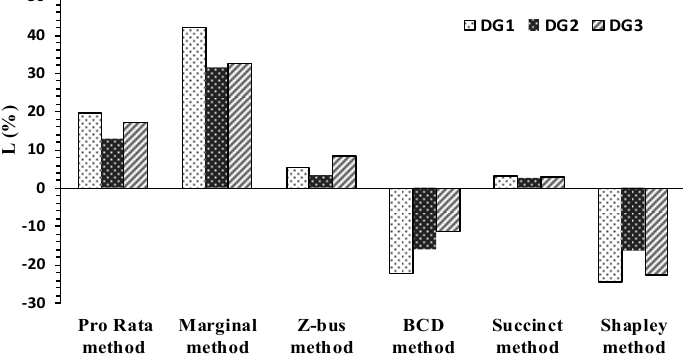
Figure 4. Comparison of different loss allocation techniques to determine the contribution of DGs.